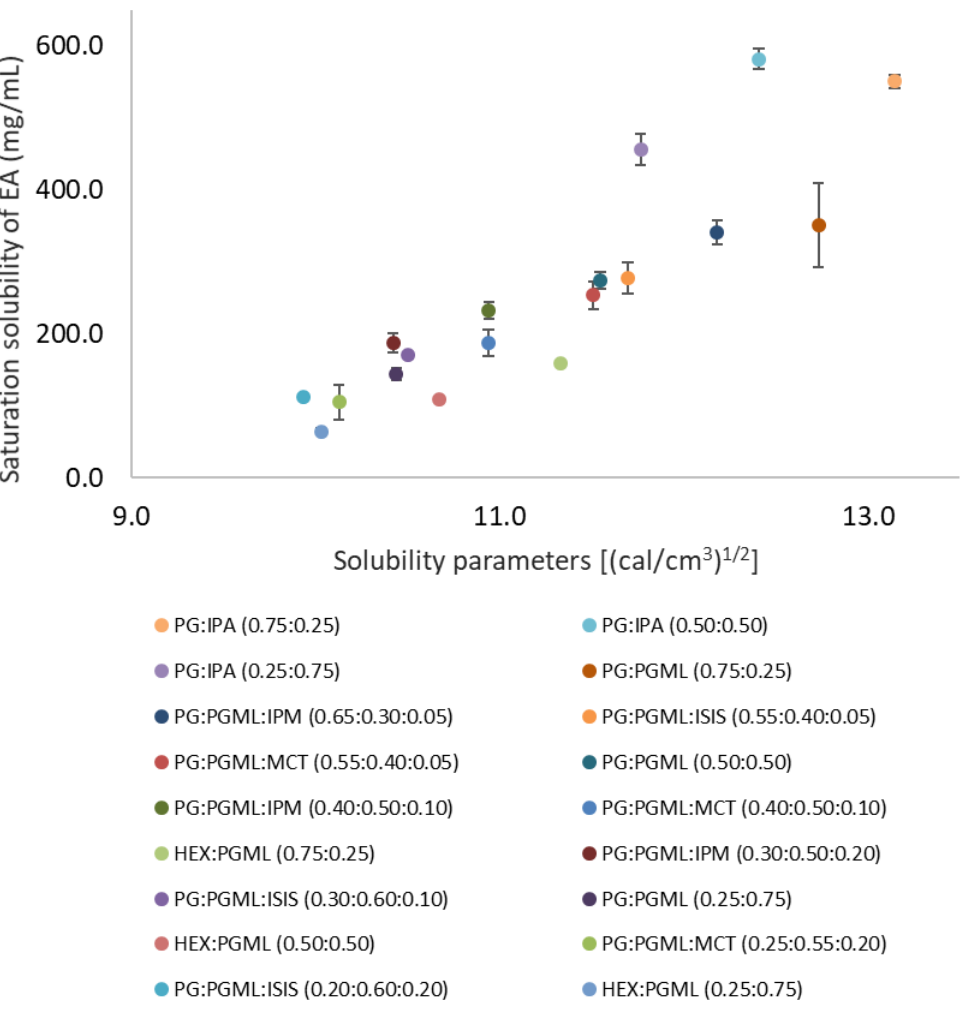
Figure 1. Solubility parameter values of various solvents plotted against saturation solubility of 3-O-ethyl l-ascorbic acid in vehicles at 32 ± 1 °C ( n = 3; mean ± SD). 3.2. Porcine Skin Permeation and Mass Balance Studies of EA Using Binary Systems of PG and HEX with